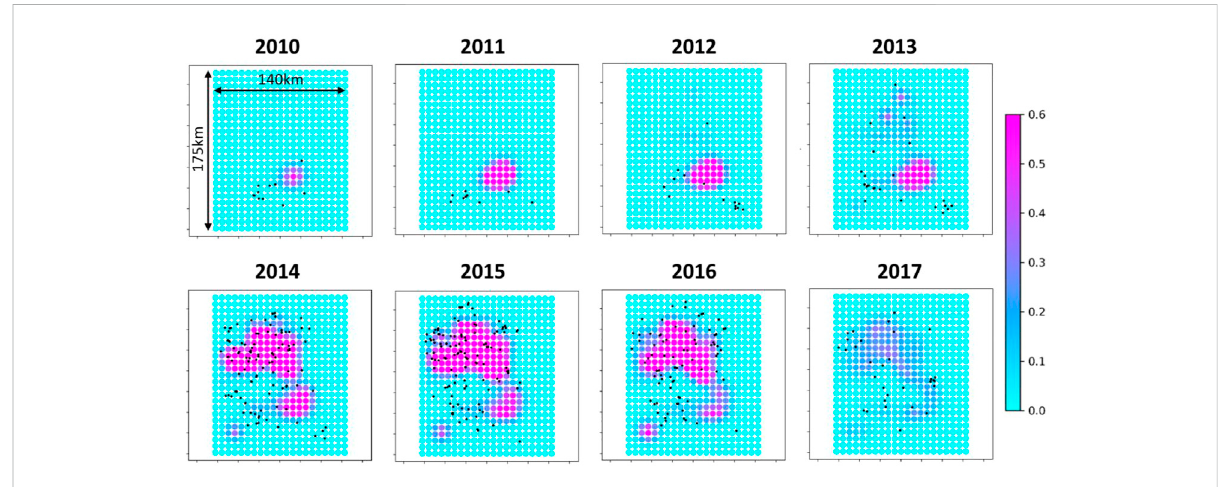
Comparison of the cumulative fi eld-wide injected volumes (up) and seismicity rates (down) for the 4 years of the optimization period. The horizontal dashed line (bottom graph) indicates the imposed threshold of 70 event/year. Note that the historical seismicity rate (blue curve in bottom graph) is similar to the mean posterior (blue curve) in Figure 9.